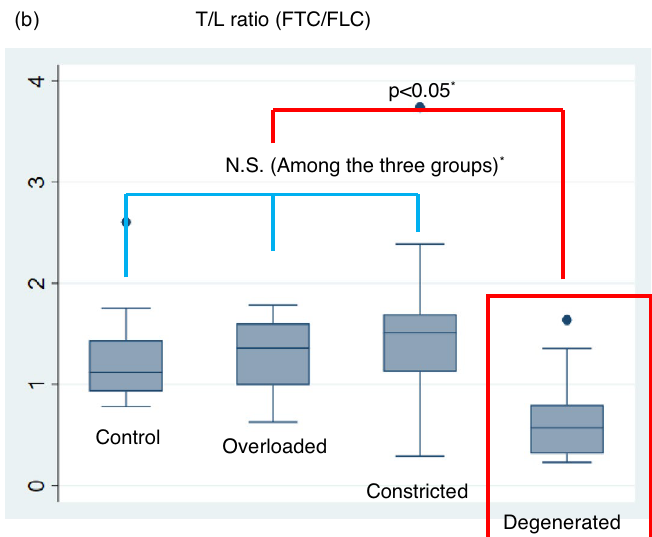
Figure 3. ( a ) Box plot of the FLC and FTC values in the four groups. The dots indicate outliers. Inequality signs indicate statistically significant differences between the four groups. The Control and Overloaded RV groups had higher FLC values than those of the Constricted RV and Degenerated RV groups. The Constricted RV group had lower FTC values than those of the Control and Overloaded RV groups. The Degenerated RV group had the lowest FTC value among the four groups. *Tukey’s test for multiple comparisons. ( b ) Box plot of the T/L ratios in the four groups. The dots indicate outliers. Inequality signs indicate statistically significant differences between the four groups. The Degenerative RV group had the lowest T/L ratio among the four groups, with an average T/L ratio of < 1 (FTC < FLC). *Tukey’s test for multiple comparisons. FLC Fractional longitudinal change, FTC Fractional transverse change, T Transverse, L Longitudinal, RV Right